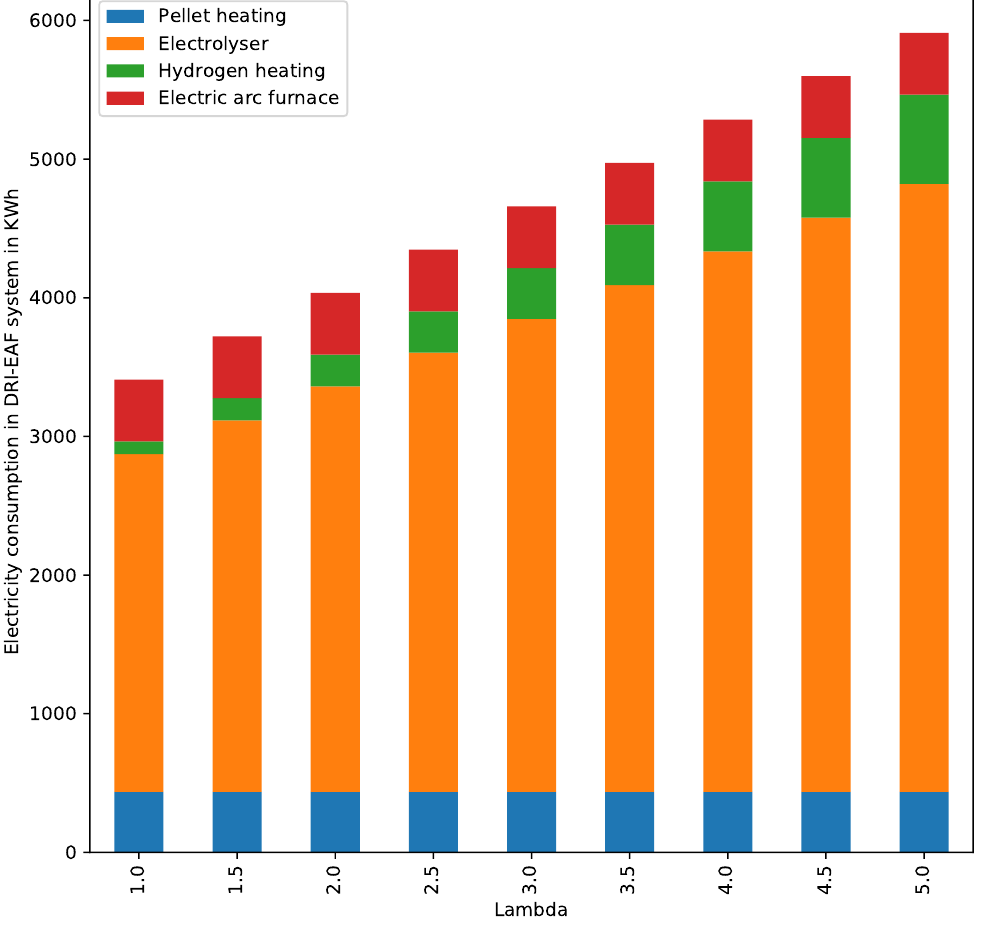
Figure 9. Variation of electricity demand (in KWh) in DRI-EAF system with varying mass flow rate of hydrogen in the DRI shaft